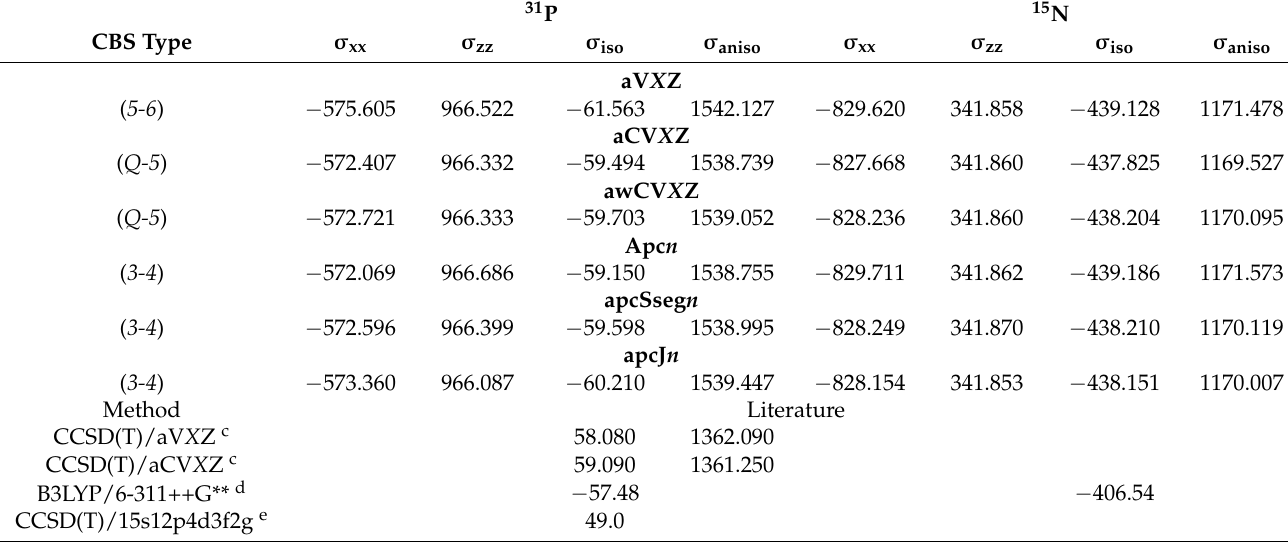
a Basis sets selected for fitting are in parenthesis (e.g., CBS( 5-6 ) is calculated using the Dunning basis sets aV 5 Z and aV 6 Z; for Jensen basis sets, CBS( 3-4 ) denotes extrapolation with apc 3 and apc 4 ). b All NMR calculations were